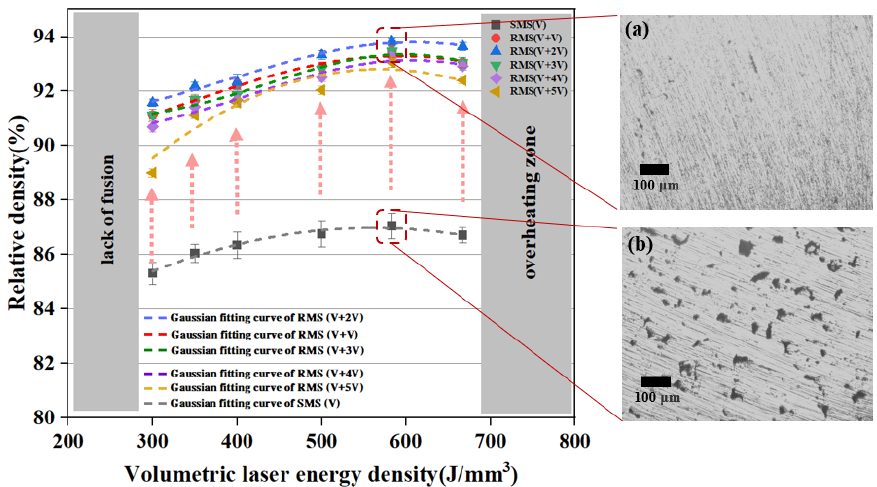
Figure 5. Relationship between the volumetric laser energy density and corresponding relative density for Cu parts ( V = 200 mm/s). The insets ( a , b ) are the corresponding micrographs of the polished sample for the RMS and SMS processing strategies.